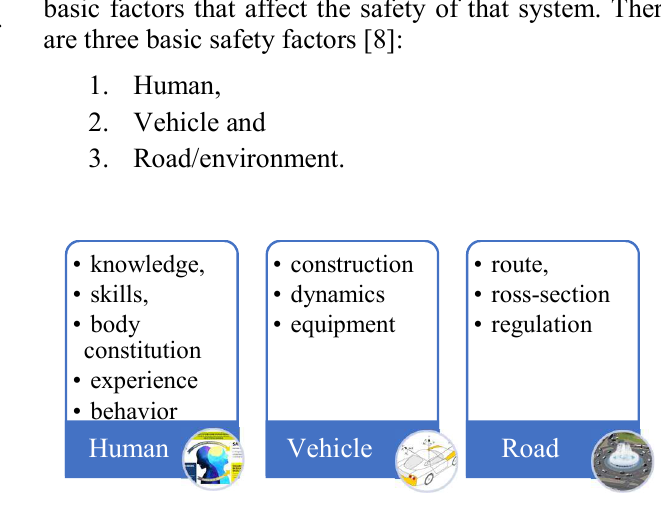
Figure 2. Main characteristics of safety